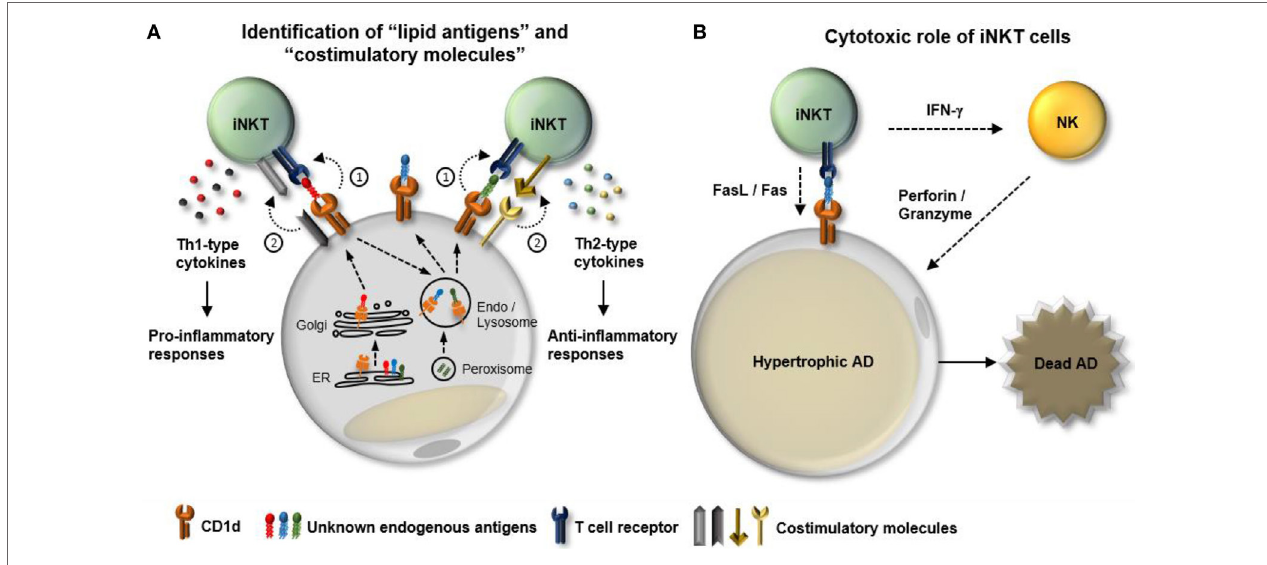
FigURe 2 | Potential mechanisms involved in the interplay between adipocytes and adipose invariant natural killer T (iNKT). iNKT cells play a crucial role in dampening obesity-induced white adipose tissue (WAT) inflammation. In particular, adipocytes act as major antigen-presenting cells that regulate the activity and the number of iNKT cells in WAT. However, the regulatory mechanisms that modulate interplay between adipocytes and adipose iNKT cells in obesity are still unclear. (A) Function of adipose iNKT cells is influenced by (1) “lipid antigens” loaded on CD1d and (2) “co-stimulatory molecules.” In obesity, a variety of factors can lead to dynamic changes in both types of lipid antigens and combination of costimulatory molecules, resulting in alteration of the functionality of adipose iNKT cells. (B) In addition to cytokine production, iNKT cells have the ability to directly or indirectly induce apoptosis. iNKT cells can express fasL and activate NK cells to kill target cells. NK cells activated by IFN- γ secrete perforin/granzyme to promote cell death processes. One of the characteristics of obese WAT is an increase in the number of hypertrophic adipocytes that are susceptible to apoptosis. Therefore, it would be interesting to determine whether adipose iNKT cells can contribute to obesity-induced death of hypertrophic adipocytes in